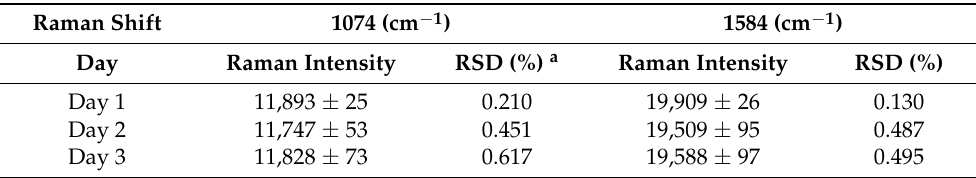
Table 3. Reproducibility test for dendritic forest-like Ag nanostructures deposited on a Si wafer.